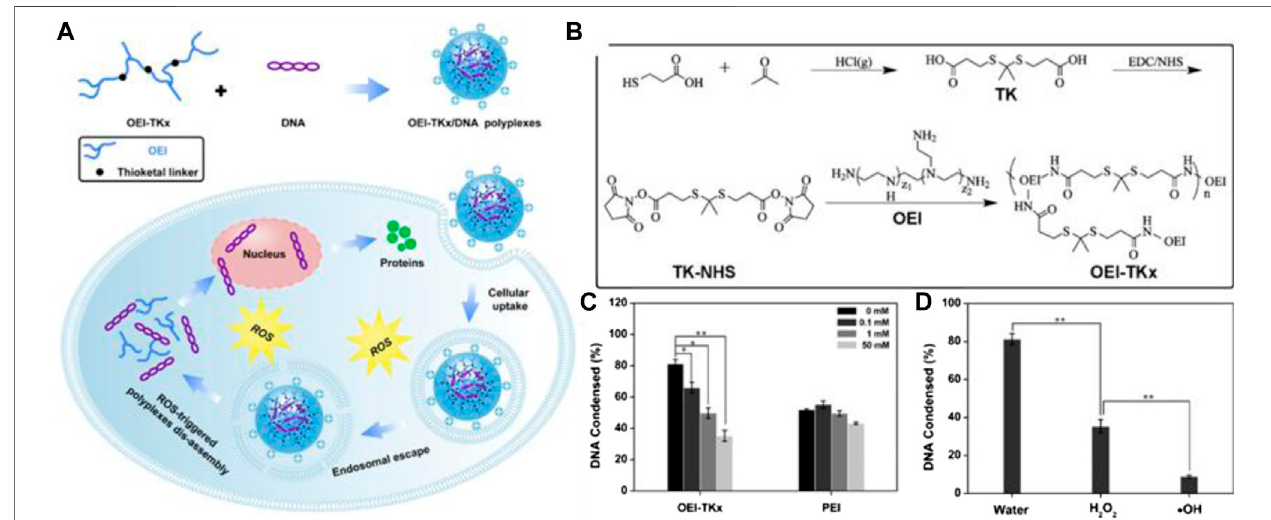
FIGURE 7 | (A) Schematic diagram of OEI-TKx/DNA polyplexes for gene delivery. (B) Synthetic routes of the TK-containing cross-linkers and OEI-TKx. (C) Percentage of DNA condensation with different H 2 O 2 concentrations; the gene release ef fi ciency of OEI-TKx/DNA polyplexes was determined by the EtBr exclusion assay. (D) Graph of ROS-responsive DNA release from OEI-TKx/DNA under various conditions (Zhang et al., 2019). Copyright 2019, the American Chemical